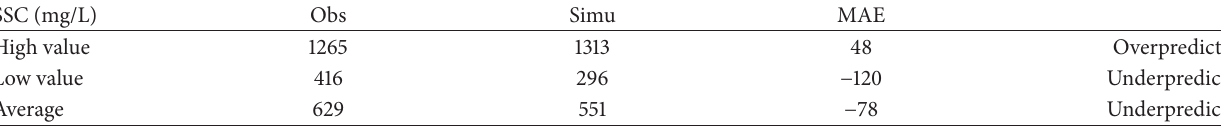
Table 3: Comparison of simulation results from three new sediment rating curves and common sediment rating curve in DRB. Common Trial A Trial B Trial C SSC (Mg/L) Obs Sim MAE Sim MAE Sim MAE Sim MAE High value 1265 1313 48 1283 18 1306 1274 Low value 416 296 − 120 325 − 91 328 − 88 343 − 73 Total average 629 551 − 78 564 − 65 572 580 − 49 𝑅 2 0.821 0.845 0.852